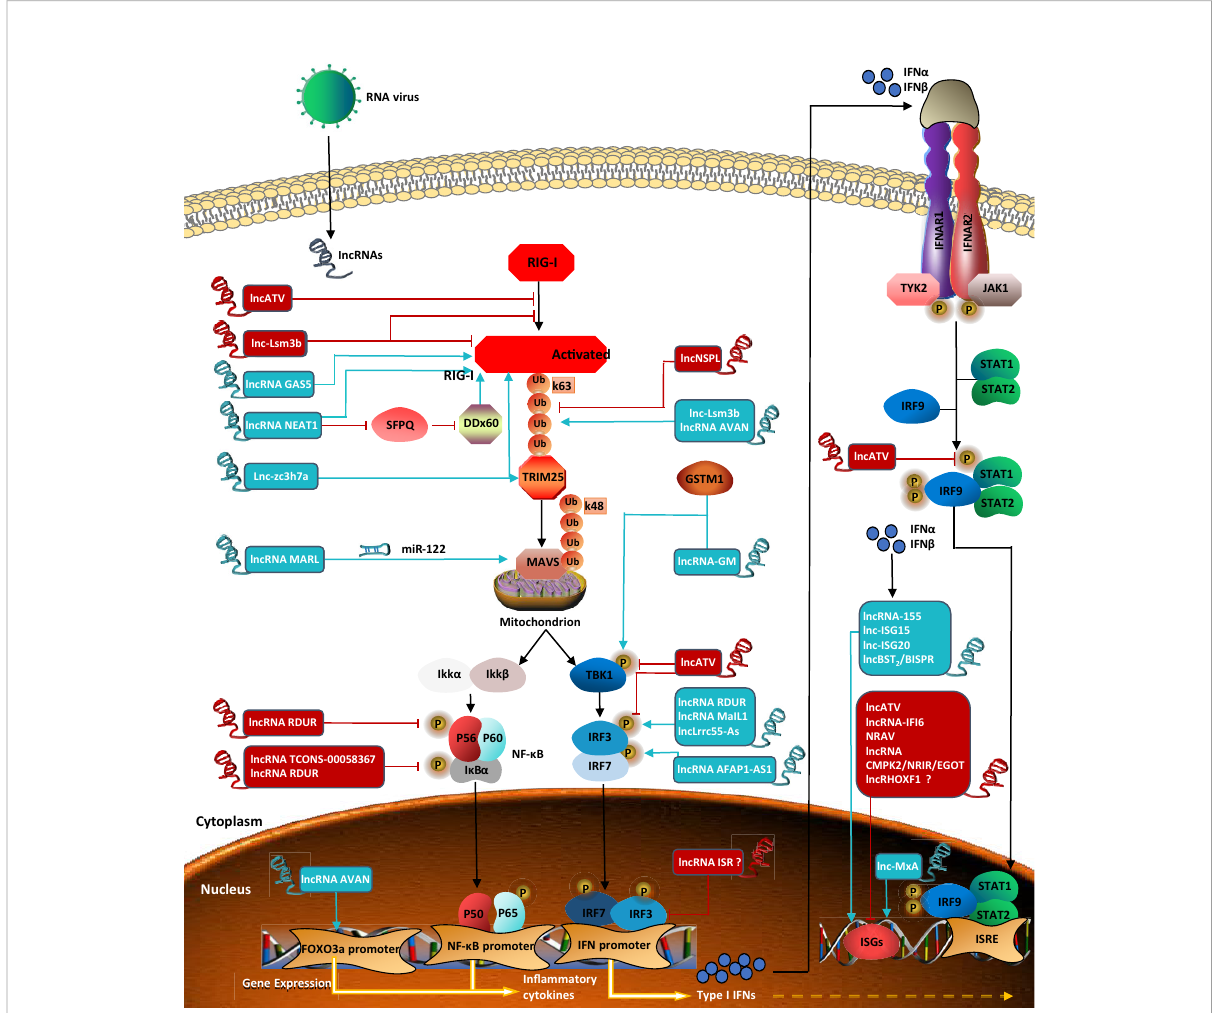
FIGURE 2 LncRNAs regulate RIG-I signaling pathway in viral infection. Lnc-Lsm3b inhibits the activation of RIG-I Lnc-Lsm3b inhibits the activation of RIG-I and affects ATPase. LncRNA GASS positively regulate RIG-I. LncRNA NEAT1 positively regulates the expression of RIG-I and DDX60. LncNSPL inhibits TRIM25-mediated RIG-I ubiquitination. Lnc-Lsm3b and lncRNA AVAN promote TRIM25-mediated polyubiquitination of RIG-I Lnczc3h7a binds to both TRIM25 and the RIG-I to facilitate TRIM25-mediated K63-linked ubiquitination of RIG-I. LncRNA MARL controls theexpression of MAVS by miR-122. LncRNA RDUR reduce the phosphorylation level of both p65 and I k b. LncRNA TCONS-00058367 reduces the phosphorylation level of transcription factor p65. LncRNA-GM induces TBK-1 phosphorylation. Lnc-ATV antagonizes virus-stimulated phosphorylations of TBK1 and IRF3. LncRNA RDUR, lncLrrc55-As, and lncRNAMaIL1 induce IRF3phosphorylation. LncRNA AFAP1-AS1 induces IRF7 phosphorylation. LncRNA AVAN positicely regulates the transcription of FOXO3a in the nucleus. LncRNA ISR and lnc-MxA are both ISGs. Lnc-MxA regulates RIG-I signaling pathway positively. LncRNA ISR negatively regulate IFNs-activated signaling, but it is unknown whether IRF3 and IRF7 are involved in the regulation of the expression. LncRNA-155, lnc-ISG15, lnc-ISG20 and lncBST2/BISPR activate ISGs transcription. Lnc- ATV, lncRNA-IFI6, NRAV, and lncRNA CMPK2/NRIR/EGOT suppress innate antiviral response by negatively regulating ISGs, but whether lncRHOXF1 directly regulates ISGs expression is unknown. LncRNA in blue represents positive regulators; lncRNA in red negative regulators for RIG-I signaling